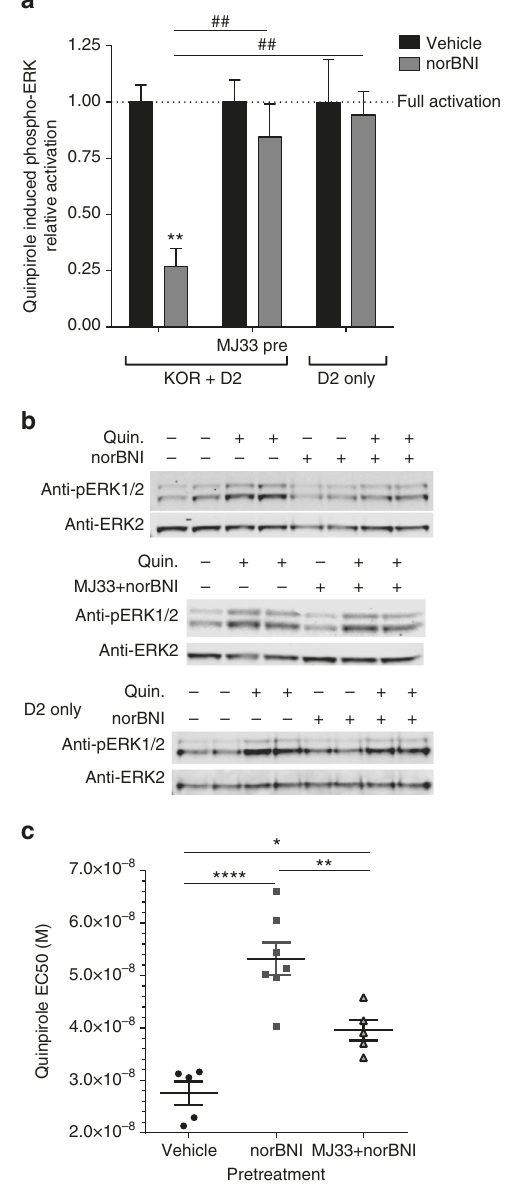
Fig. 6 PRDX6 mediates GPCR cross-tolerance. a MycKOR expressing or wild-type HEK293 cells transiently transfected with HA-D2DR(L) were pretreated with vehicle or MJ33 (10 µ M) 30 min prior to being treated for 3-5 h with vehicle or norBNI (10 µ M). Cells were then treated with 5 min with vehicle or quinpirole (100 nM) and cell lysates analyzed for phospho- ERK1/2 immunoreactivity. NorBNI reduced quinpirole-stimulated ERK1/2 phosphorylation; the norBNI inhibition of quinpirole response was blocked by MJ33 pretreatment and not observed in cells only expressing HA-D2DR (L). (Two-way ANOVA; signi fi cant interaction ( P < 0.05), signi fi cant effect of norBNI ( P < 0.01), and signi fi cant effect of KOR or MJ33 ( P < 0.05),